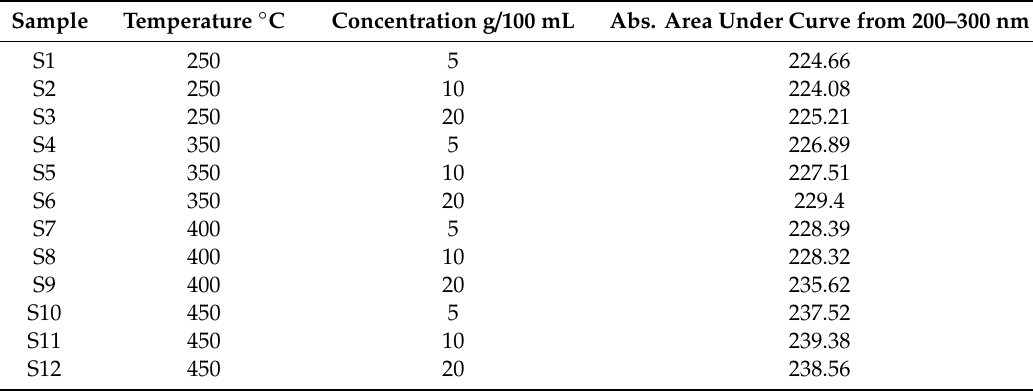
Table 1. Absorbance area under the curve of the di ff erent